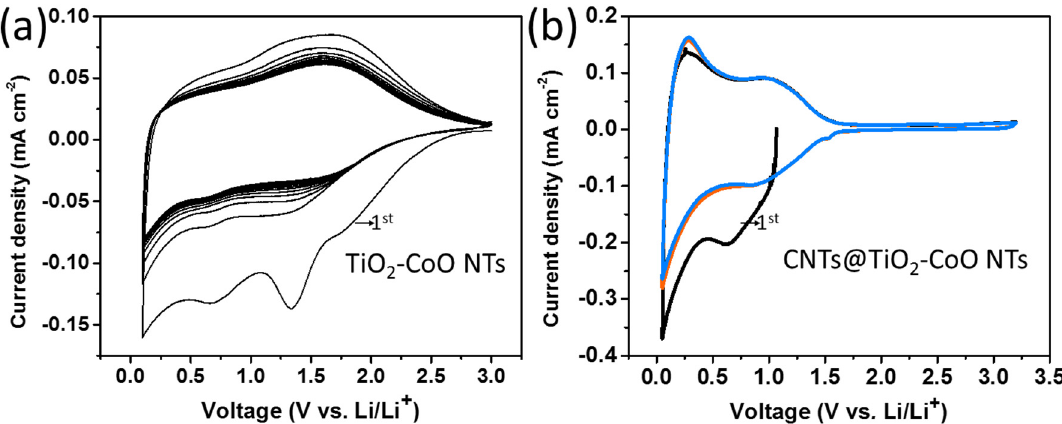
Figure 4. Cyclic voltammograms of TiO 2 /CoO nanotubes ( a ) and CNTs@TiO 2 /CoO NTs ( b ), measured at scan rates of 0.1 mV·s − 1 vs. Li/Li + .